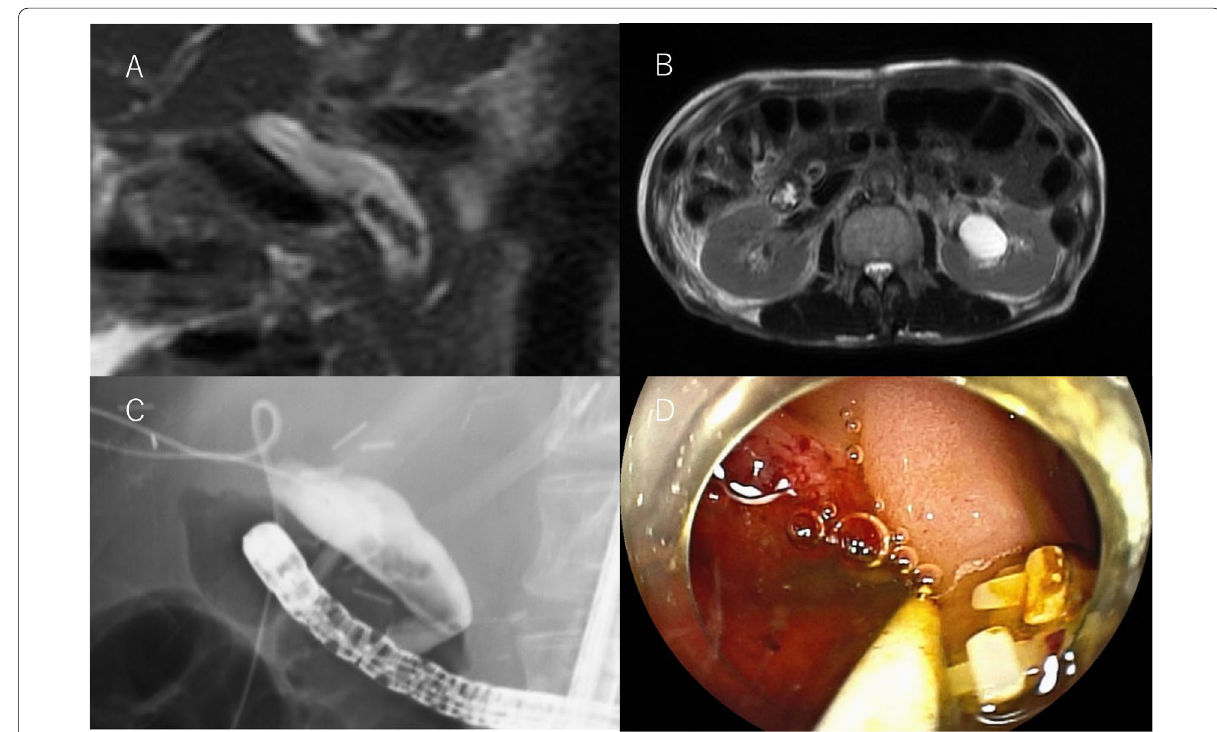
Fig. 7 Postoperative findings for case 4. A , B Postoperative follow-up MRCP image shows common bile duct stones. C Endoscopic retrograde cholangiopancreatography image shows common bile duct stones. D Two medium-large NAPCs were found with the common bile duct